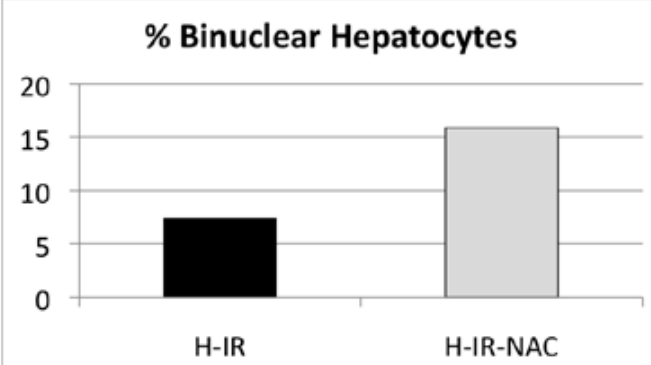
FIGURE 2 - Calculated percentage of binuclear hepatocytes ( p <0.001). NAC treatment decreased both of the enzyme activities, but only ALT was statistically significant. ALT: H-IR=636±39.1U/L and H-IR-NAC=376±127.3U/L (*p=0.023) / AST: H-IR=1259±304 U/L and H-IR-NAC=985± 347U/L (p=0.456) (Figure 3).